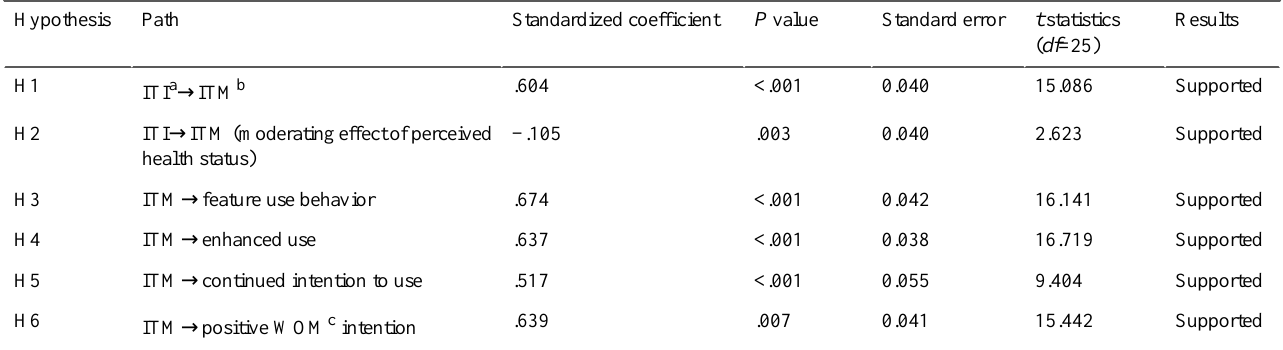
Table 5. Results of hypotheses testing.